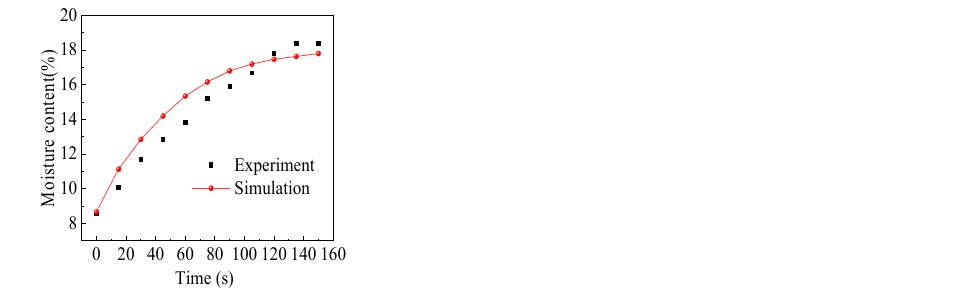
Figure 5. The comparison of the experiment and simulation of the moisture content.